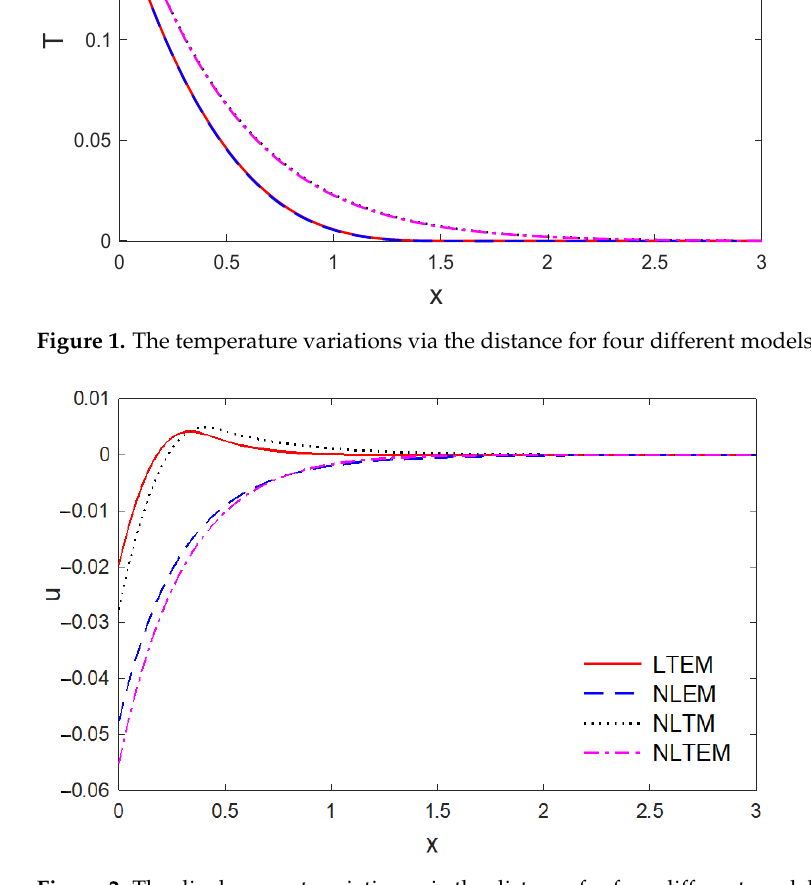
Figure 3. The stress variation via the distance for four different models.